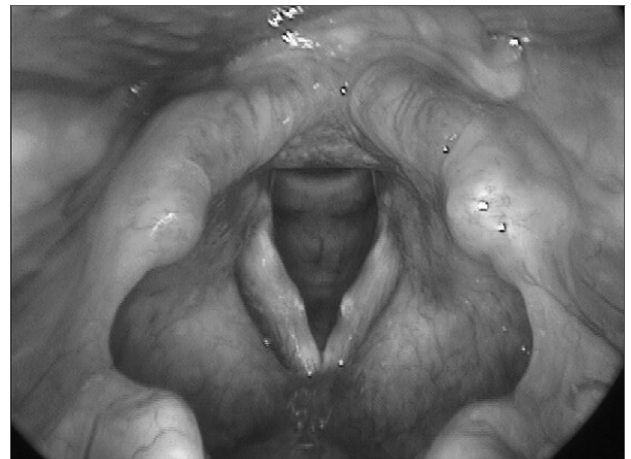
Figura 3. Nódulos vocais bilaterais.